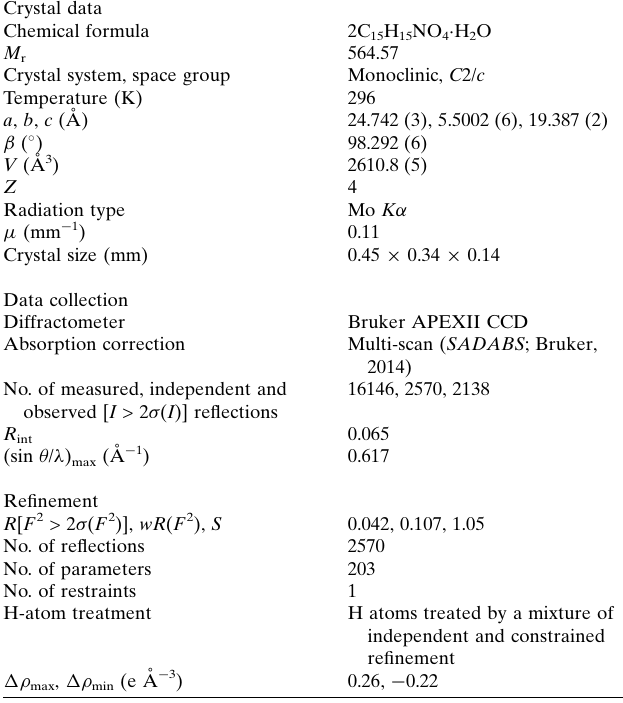
Table 2 Experimental details. Crystal data Chemical